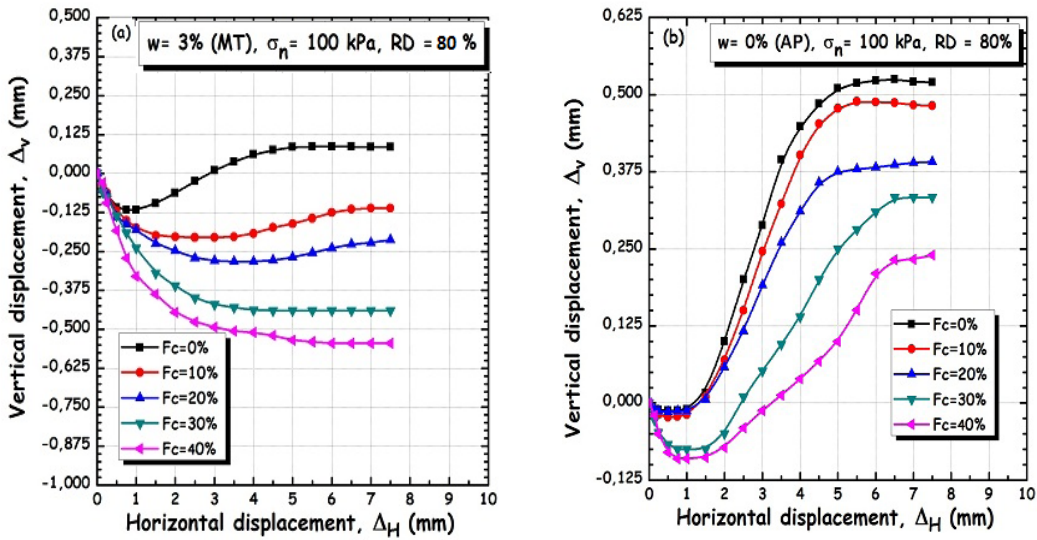
= 400 kPa): (a) variation of vertical n